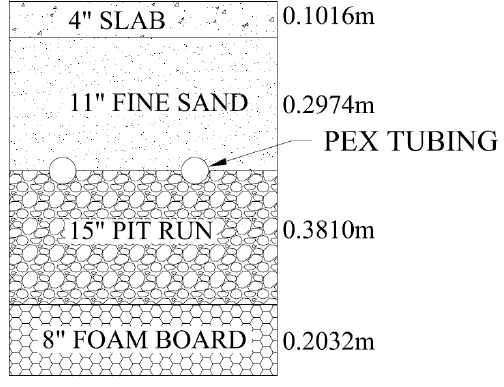
Figure 3. Cross-sectional view of solar thermal storage [15].